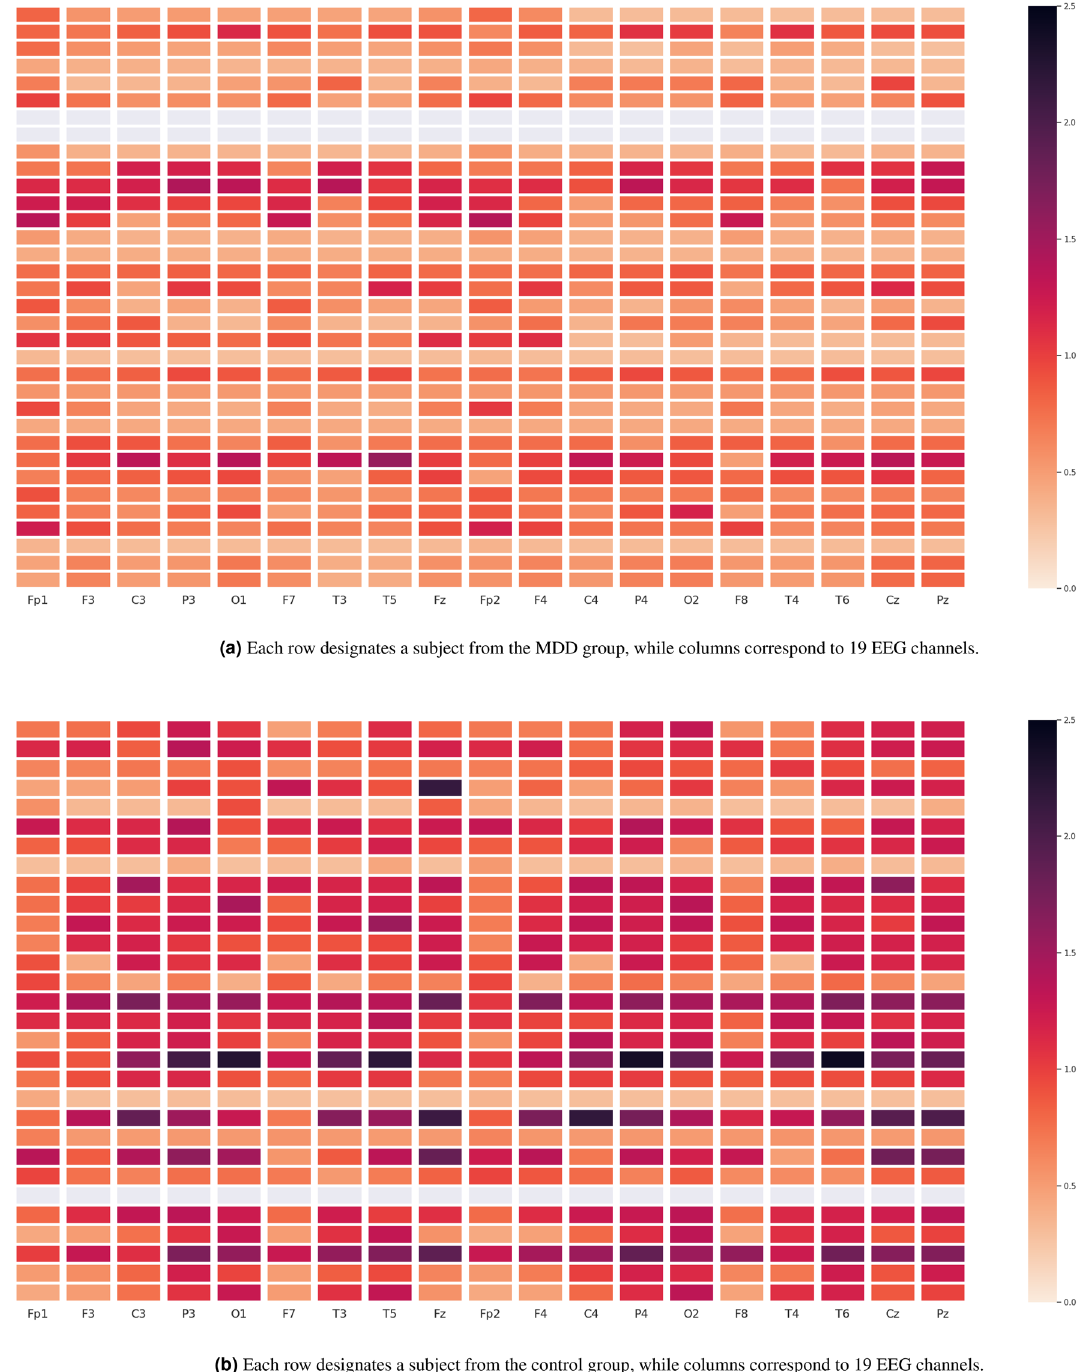
Figure 8. Heat maps of the differential entropy of action potential distributions for experiments with